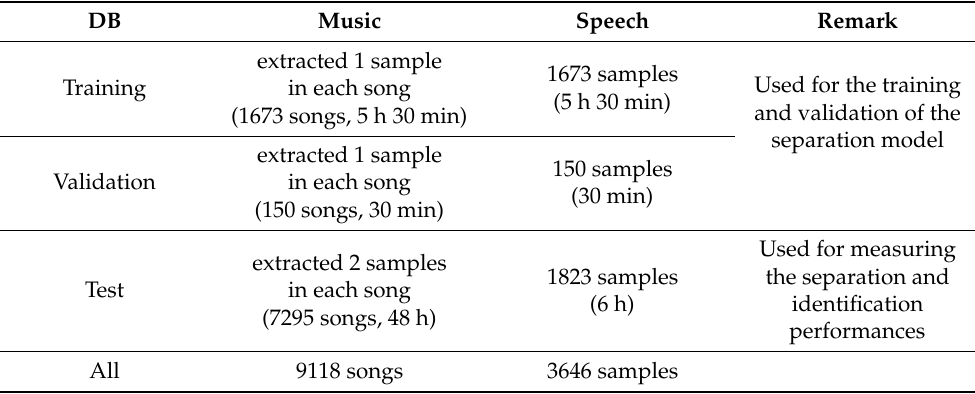
Table 6. Dataset configuration for music experiment. The sample length is 12